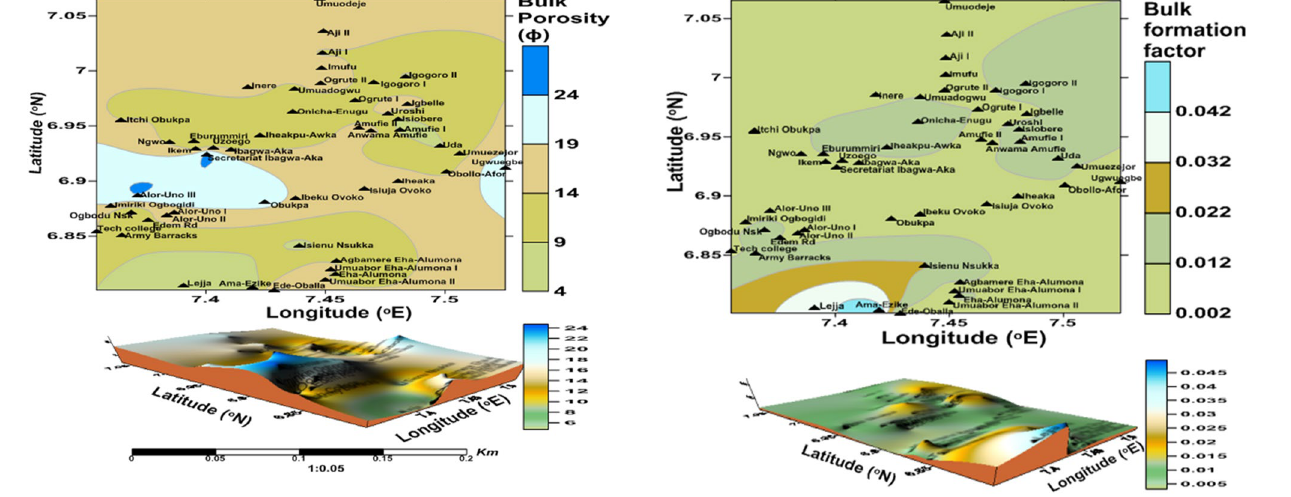
Fig. 9 2D and 3D contour map showing the variation of bulk porosity in the study area